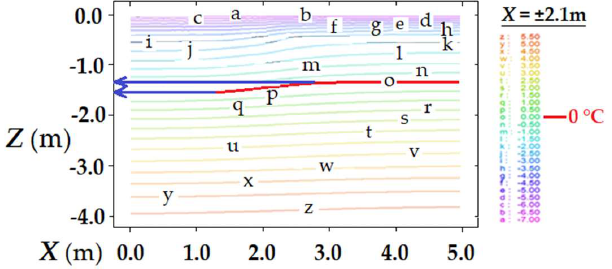
Figure 7. Experiments after the IC4 for X = ± 2.10 m—evaluation of freezing depth.